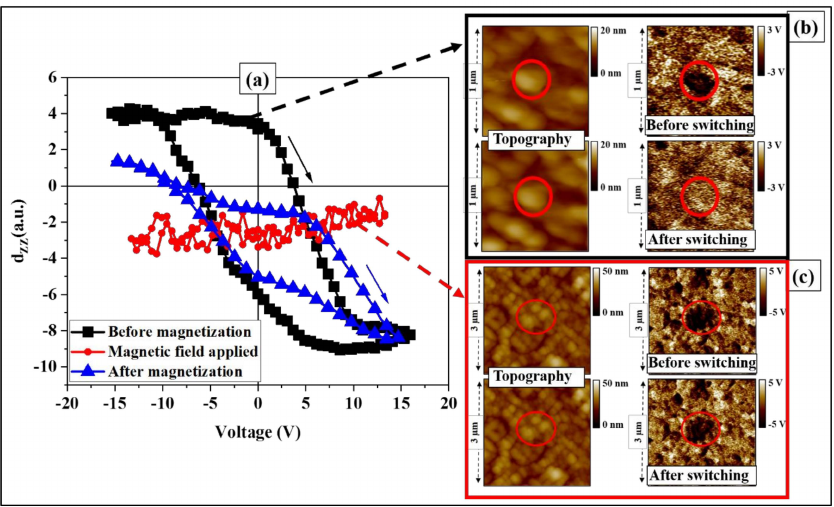
Figure 6. Suppression of ferroelectric switching by applying an external magnetic field: ( a ) piezoelec- tric hysteresis loops (d ZZ vs. V) measured before (black), during (red) and after (blue) applying a magnetic field ( ≈ 2700 Oe). The image ( b ) shows the topography and the out-of-plane piezoelectric signal (z-PFM) before and after switching of the polarization (no magnetic field is applied). The image ( c ) shows the topography and the z-PFM signal before and after applying 15V bias voltage in presence of the applied magnetic field, showing no switching of the polarization. The red circles indicate the variation of the contrast upon poling before and after applying the external magnetic field, confirming the magnetoelectric